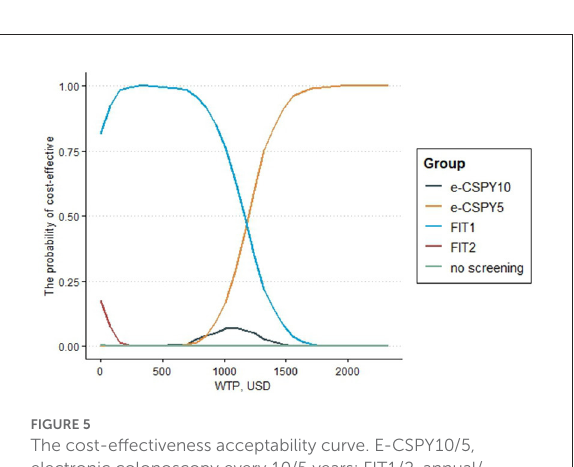
FIGURE5 The cost-effectiveness acceptability curve. E-CSPY10/5, electronic colonoscopy every 10/5 years; FIT1/2, annual/ biennial FIT; WTP, willingness to